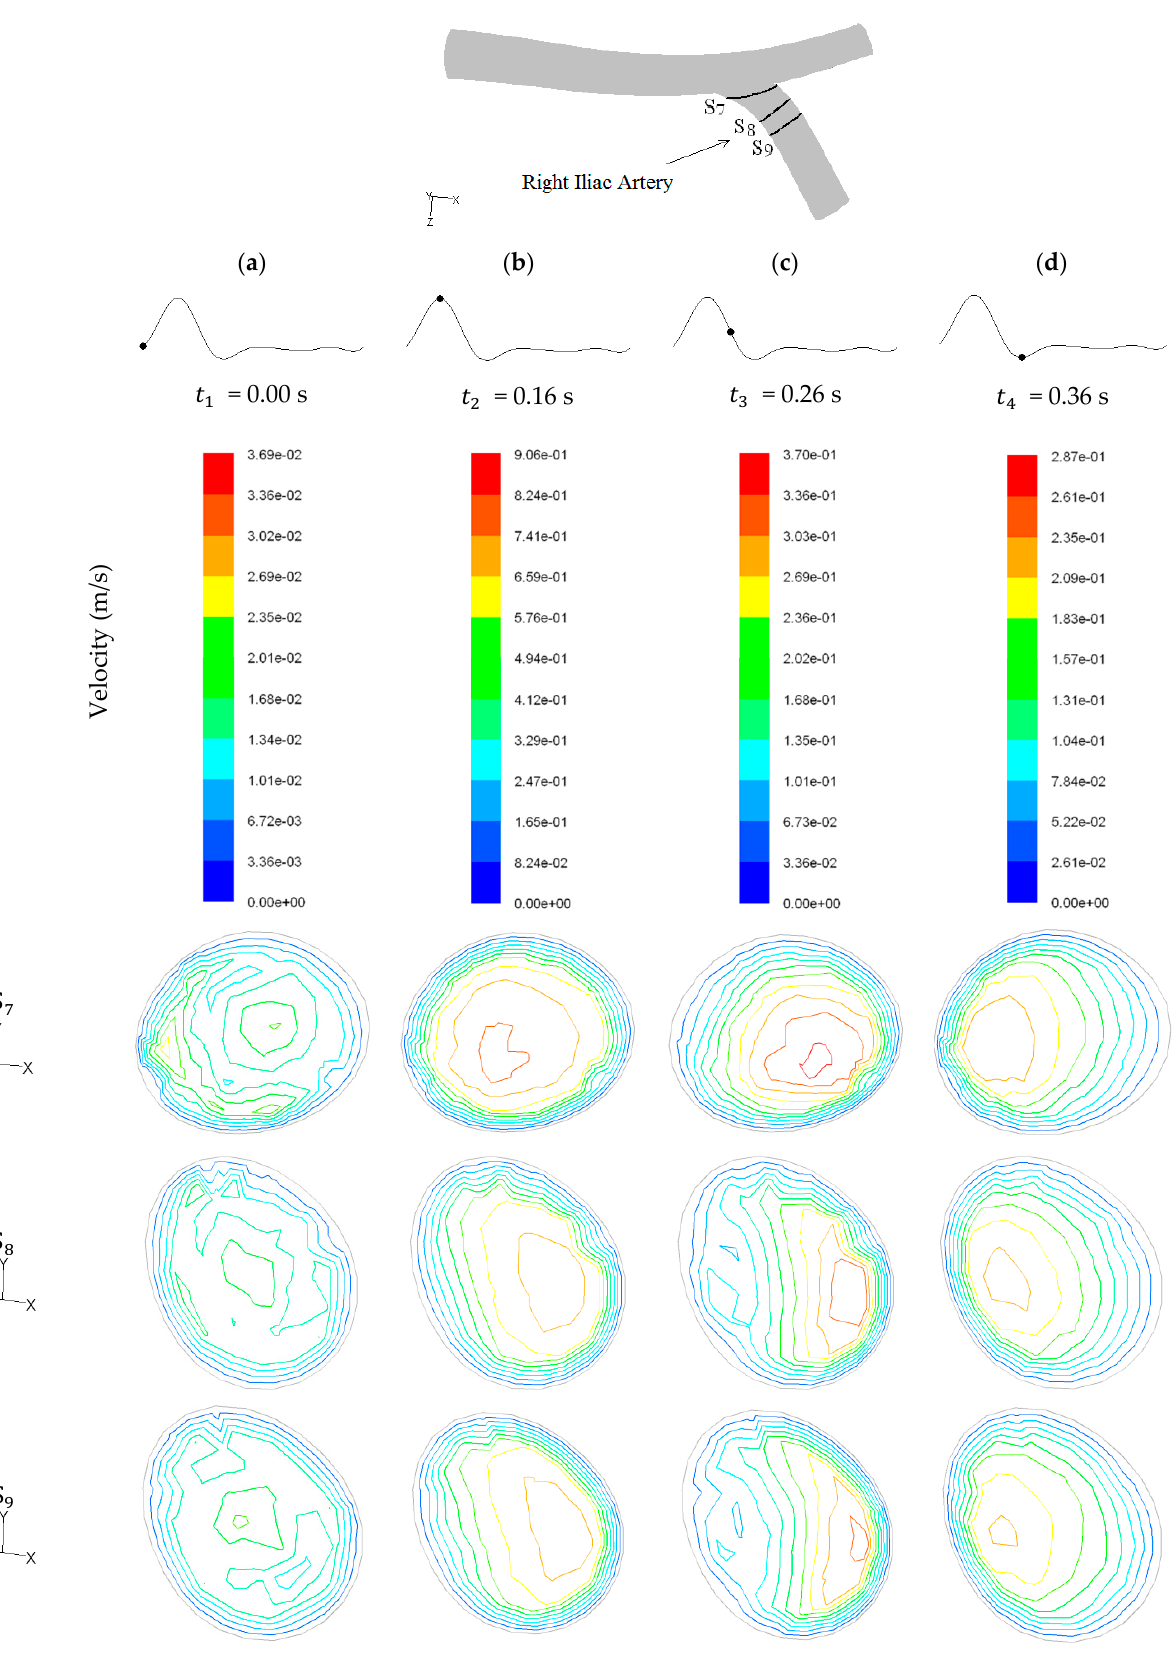
Figure 15. Velocity magnitude (m/s) for different cross-sections during the cardiac cycle at the right iliac artery, ( a ) t = 0.00 s, ( b ) t = 0.16 s, ( c ) t = 0.26 s, ( d ) t = 0.36 s.